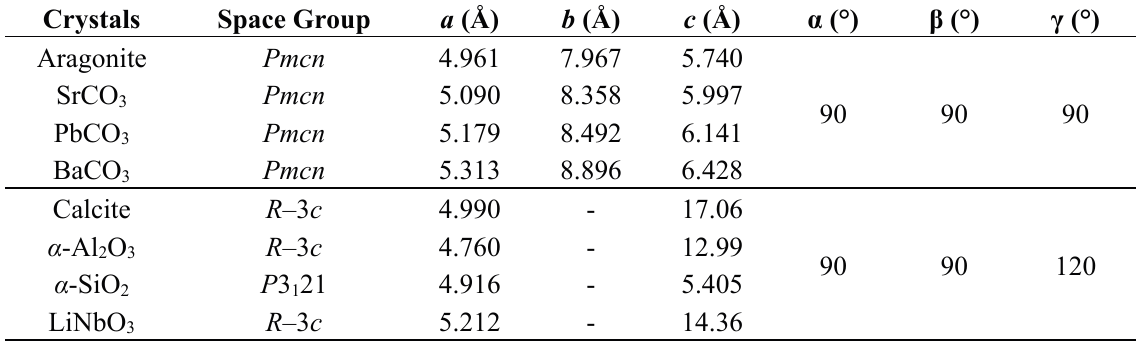
Table 1. Crystal structures of the inorganic compounds in the present study [20–25].